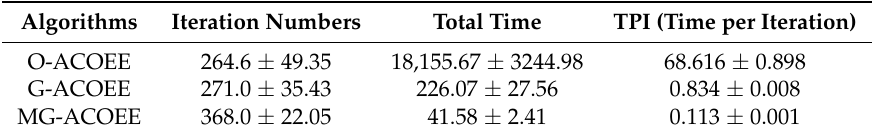
Table 8. Comparison of O-ACOEE, G-ACOEE, and MG-ACOEE (ASC) on computing performance for Urban